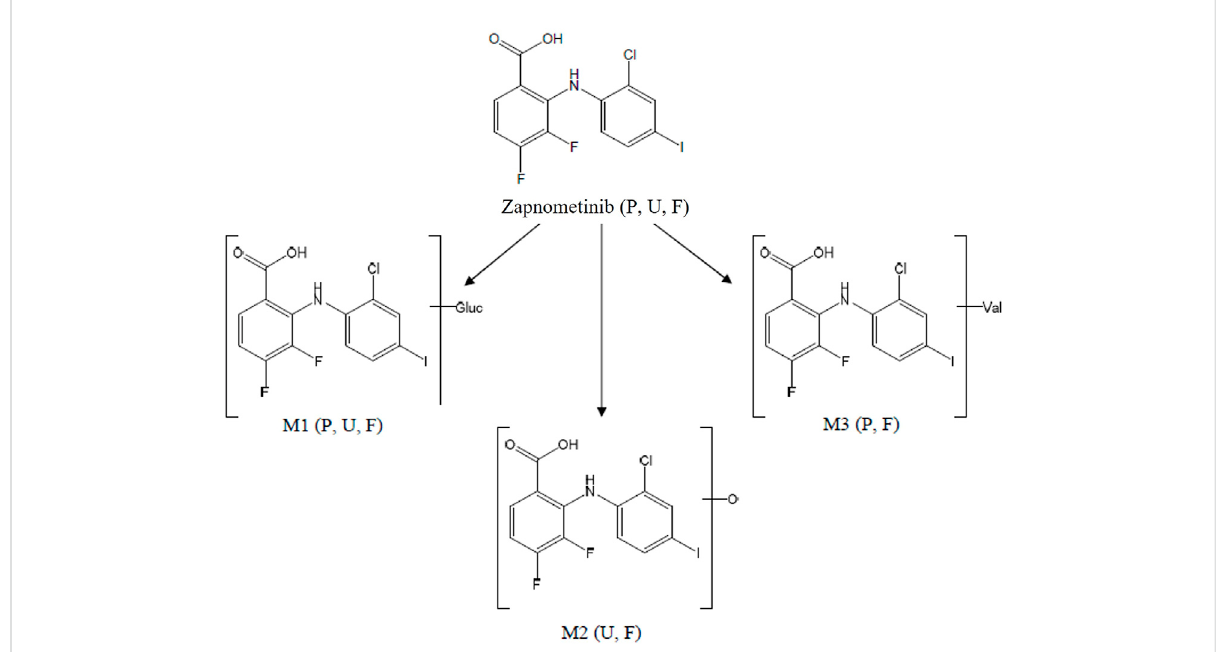
FIGURE 6 Proposedbiotransformationpathwayofzapnometinib.Metabolites(M1 – M3)identi fi ed via massspectrometryinfeces(F),plasma(P)orurine(U) in male and female rats following a single oral administration of [ 14 C]-zapnometinib (30 mg/kg), separated and quanti fi ed by HPLC with radioactivity